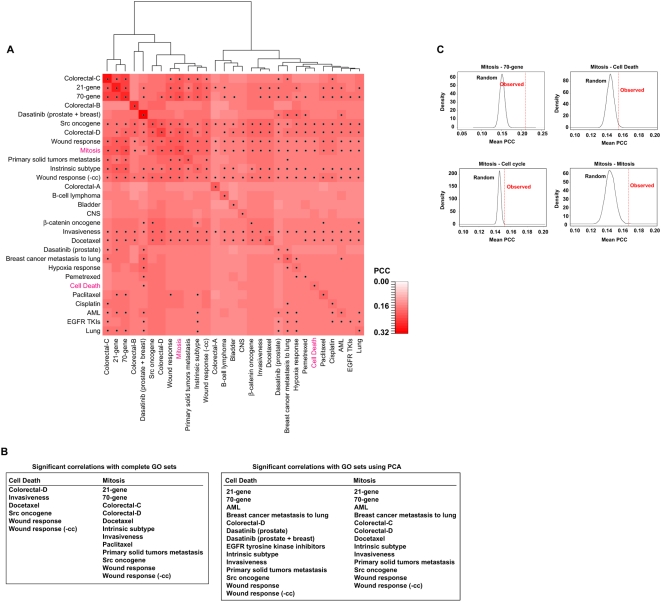
Transcriptomic correlations between signatures and with defined biological processes.
A, heat map of average PCCs between cancer signatures in a breast cancer gene expression dataset [40]. Significant co-expression (empirical P values<0.05) is indicated by dots. Note that the matrix is not symmetrical because the results were dependent on the size of each gene set; therefore, the larger gene sets (e.g. wound response or invasiveness) showed significant co-expression with many other signatures, perhaps partly due to the fact that they had greater statistical power with which to detect them. Each dot corresponds to the comparison between a signature on the left (simulated set) and a signature at the bottom. The Cell Death and Mitosis sets are highlighted in pink. B, left panel, list of signatures that showed significant correlation with the Cell Death or Mitosis complete GO sets. Right panel, list of signatures that showed significant correlation with the Cell Death or Mitosis sets, but only using their principal components. C, observed (discontinuous red line) versus expected (black curve for 10,000 randomly selected sets) average PCCs between the Mitosis set and the 70-gene set, the Cell Death set, or genes with periodic expression through the cell cycle.